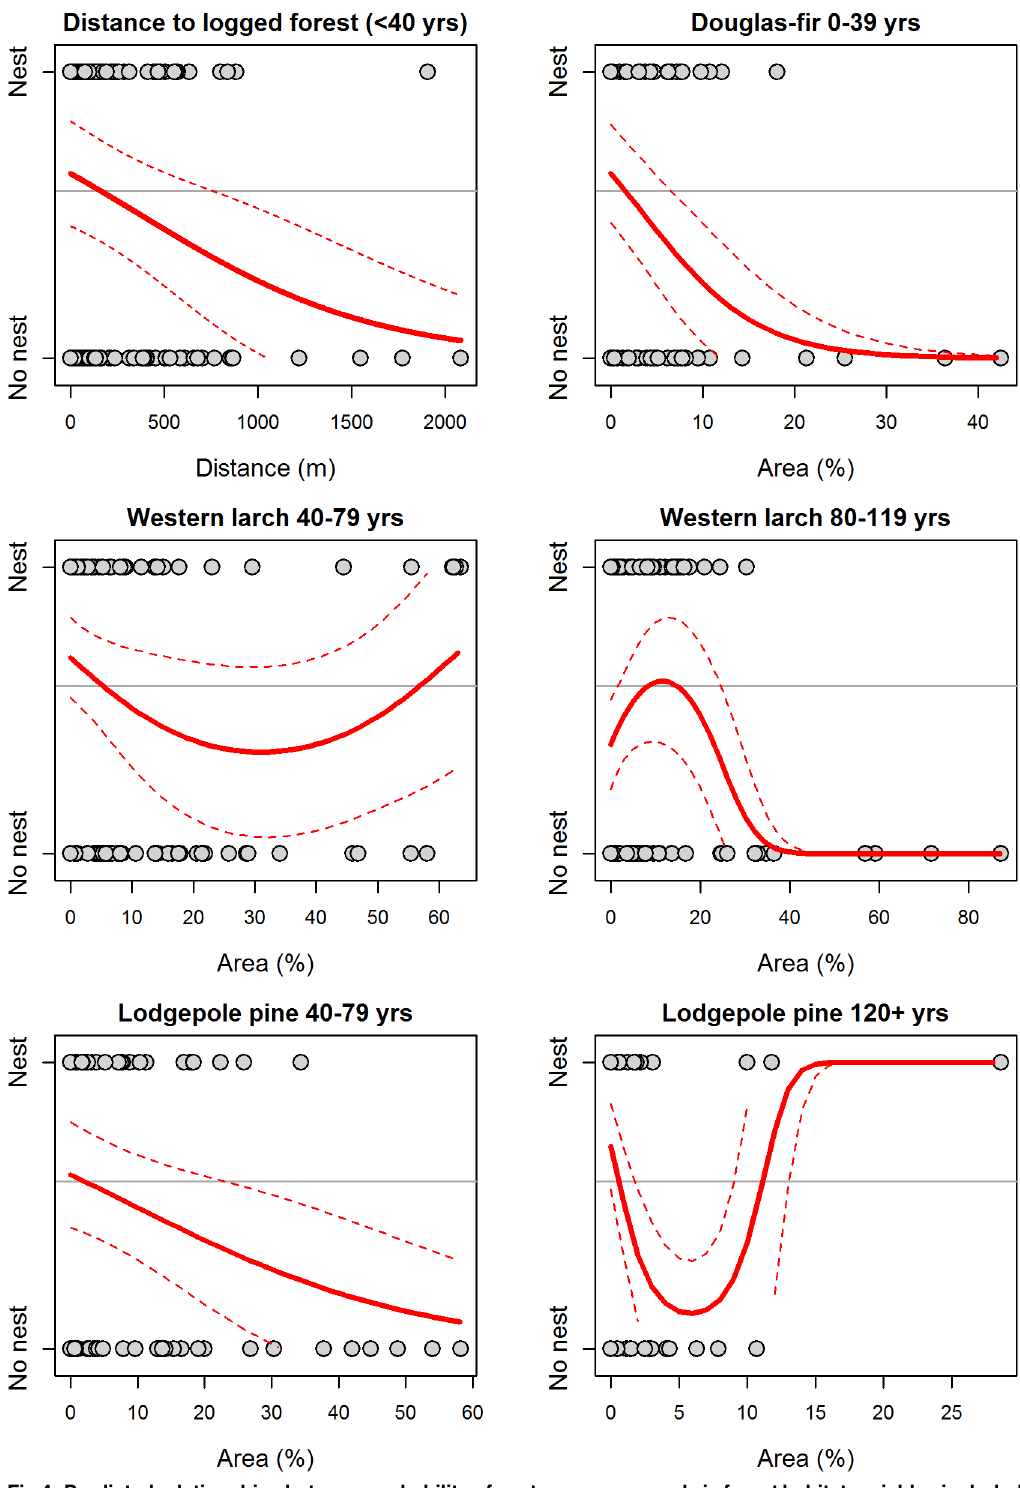
Fig 4. Predicted relationships between probability of nest occurrence and six forest habitat variables included in the GIS800 model (originally 28 variables considered) for the Okanagan-East Kootenay Region of the Williamson ’ s sapsucker Area of Occupancy in British Columbia, 2006 – 2008. Variables were calculated from geographic information system (GIS) data within an 800 m radius of the nest or random point. Grey points depict nest occurrence ( ‘ Nest ’ ) or a random point ( ‘ No nest ’ ), and the title of each plot indicates the habitat variable. Solid lines indicate predicted values and thin